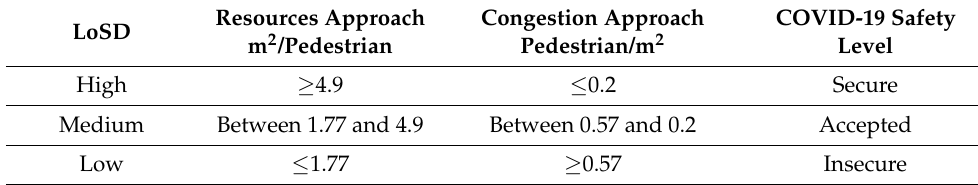
Congestion Approach Pedestrian/m 2